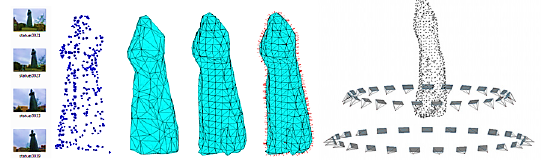
Figure 6. The statue case and its initial block